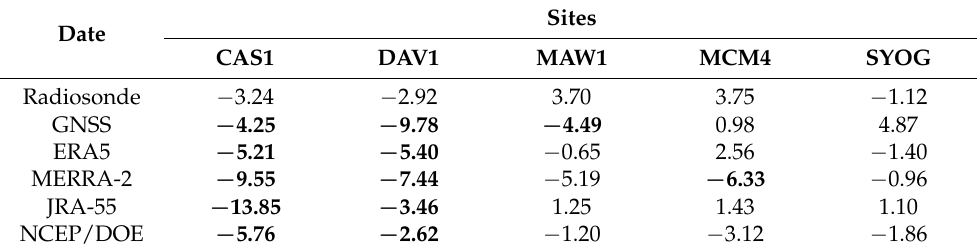
Figure 13. PWV time series averaged from radiosonde, GNSS, ERA5, MERRA-2, JRA-55 and NCEP/DOE data at the five collocated sites during the period 2001–2018: ( a ) CAS1, ( b ) DAV1, ( c ) MAW1, ( d ) MCM4 and ( e ) SYOG. Table 5. Statistical results of relative PWV trends (in % decade − 1 ) from radiosonde, GNSS, ERA5, MERRA-2, JRA-55 and NCEP/DOE data at the 5 collocated sites from 2001 to 2018. Significant trends are highlighted in bold